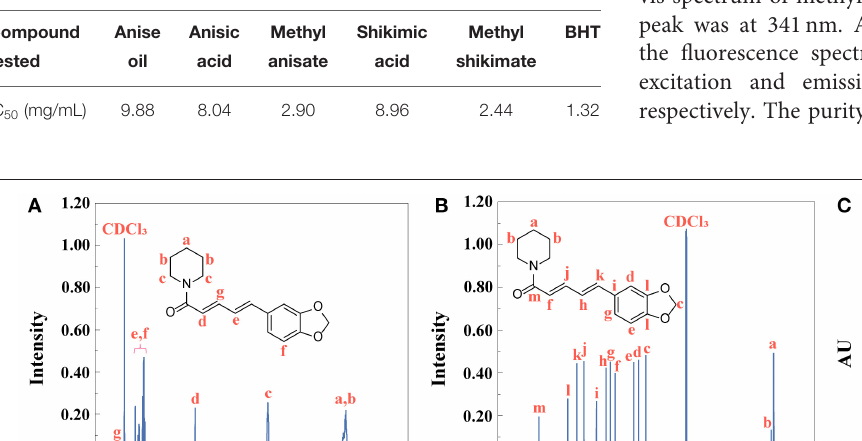
TABLE 2 | IC 50 value of tested compounds.